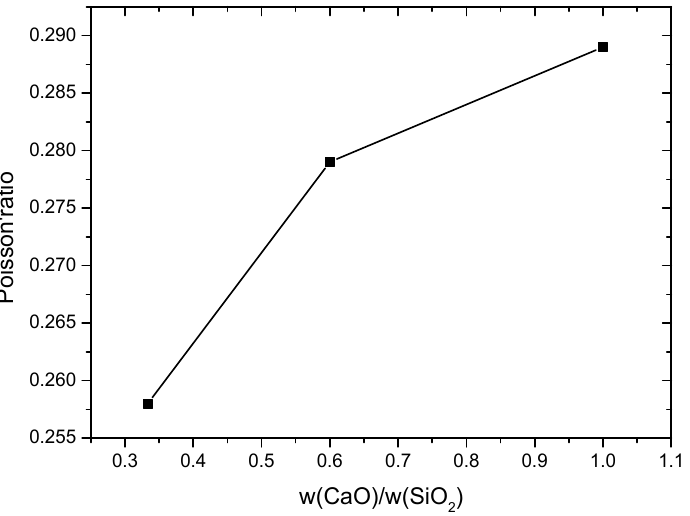
Figure 2. The measured Young’s modulus values as a function of basicity (w(CaO)/w(SiO 2 )). The basicity dependence of Poisson’s ratio of glassy sample was plotted in Figure 3. It can be seen in the figure that the Poisson’s ratios of samples are enhanced with increas- ing basicity. A high Poisson’s ratio of a glass is found when the rigid glass structure is softened [23]. It is well known that the increase of CaO would lead to more non-bridging oxygen, which would break the linkage of various silicate tetrahedrons [26] and loosen or even brake the rigid 3D silicate network, leading to increased Poisson’s ratios.